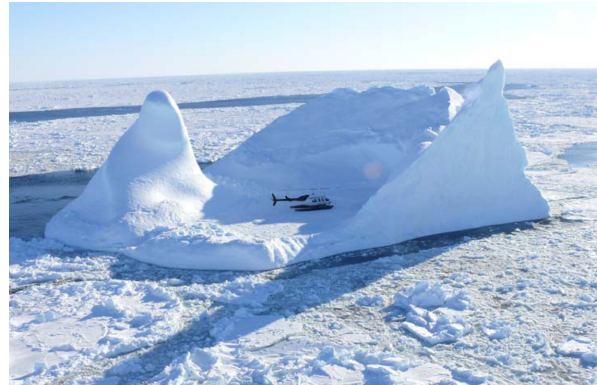
Figure 3. Helicopter landed on iceberg for tracker deployment. Ice- berg between Makkovik and Hopedale, Canada. Bell 206L heli- copter, fuselage length 10.13m. Image courtesy of S. Prisenberg (Prinsenberg et al., 2012).